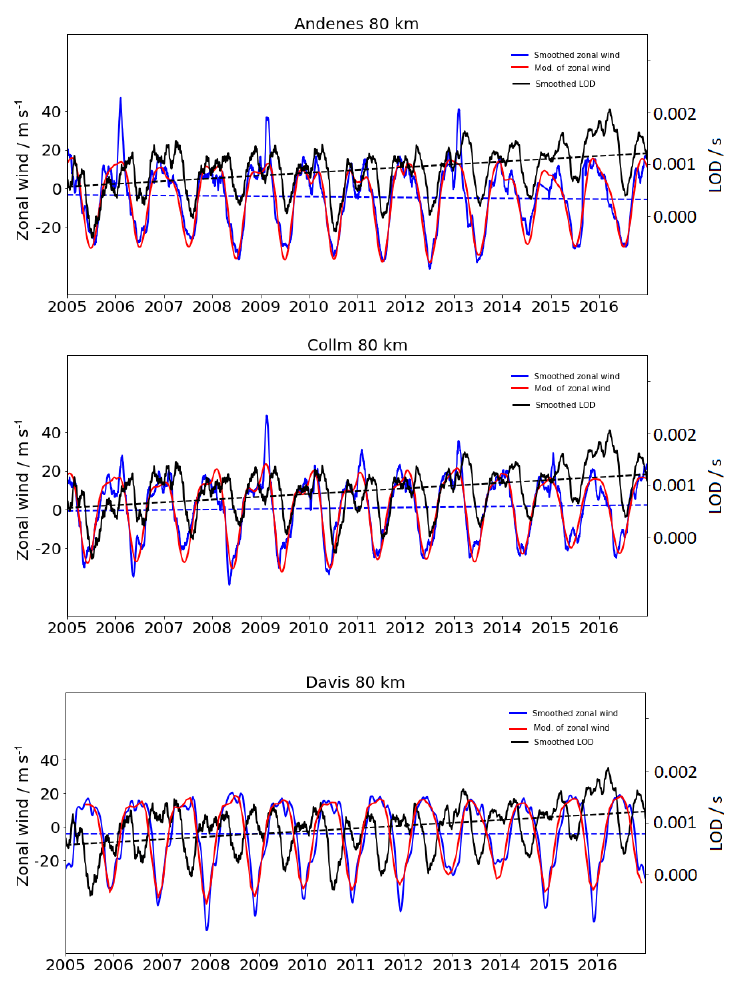
Figure 6. Smoothed zonal wind (blue) values based on meteor radar wind data at 80km and smoothed LOD (black) values. The modulation of the smoothed zonal wind is displayed in red after removing the impact of the solar cycle. All curves are done by smoothing over several days, without removing the day-to-day variations, to show the seasonal pattern of the parameters. The dashed lines correspond to the tendency of the wind and LOD based on linear